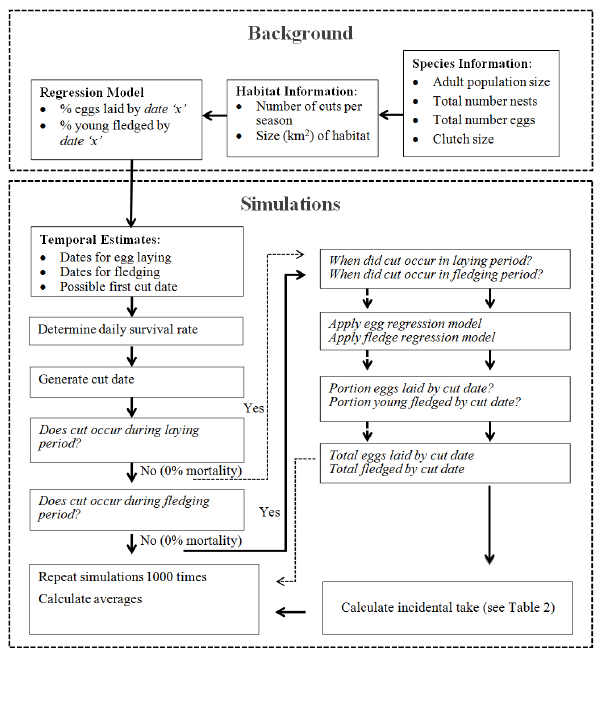
Fig. 2 . Simplified flow chart for calculating incidental